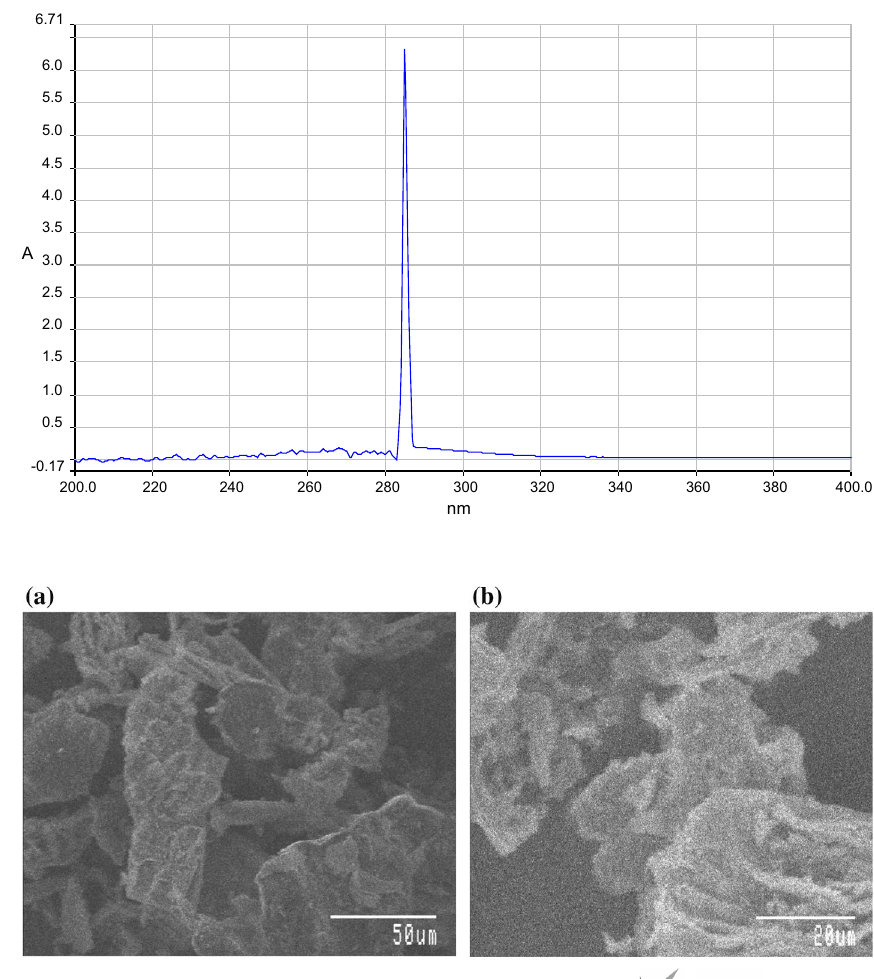
Fig. 1 UV–vis spectrophotom- eter of GO nanoparticle